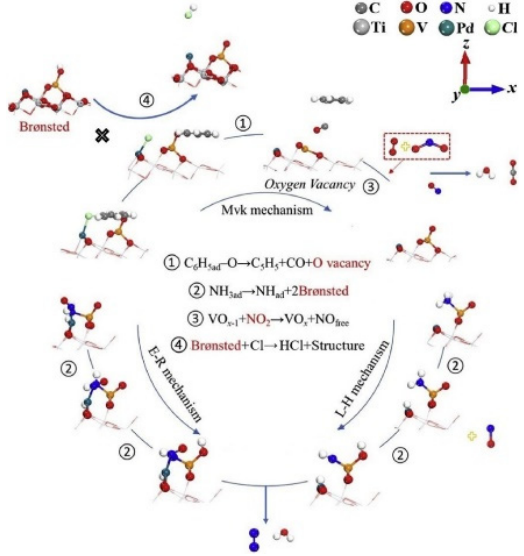
Figure 3. The NH 3 -TPD ( a ) and NO-TPD (b) profiles of the fresh and CB pre-treated catalysts. Reac- tion conditions: NO, 500 ppm (when used); CB, 50 ppm (when used); NH 3 , 500 ppm (when used); N 2 as the balance gas [88]. Copyright The Royal Society of Chemistry 2019.